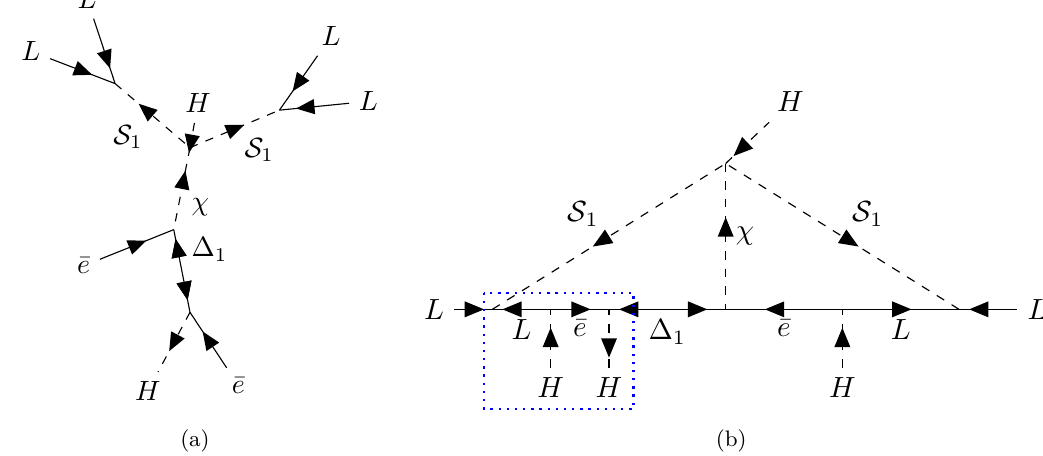
Figure 16. (a) The furnishing of the tree-level topology, labelled 2 s 6 f 4 in our scheme, that generates O 62 b at tree level. The interactions allowed in the theory are such that the ∆ 1 line can be connected straight into one of the LL S 1 vertices in place of an L , leading to a loop-level completion of O 2 . (b) The neutrino self-energy diagram relevant to the non-genuine completion of O 62 b . It is clear that this diagram does not represent the dominant contribution to the neutrino mass, since the highlighted collection of fields can be replaced with the interaction ¯∆ 1 L S 1 . This leads to a diagram with heavy loop involving ∆ 1 , χ and S 1 , which dominates the neutrino masses. In both cases, the relevant topology is CLBZ-7 in the classification of ref.